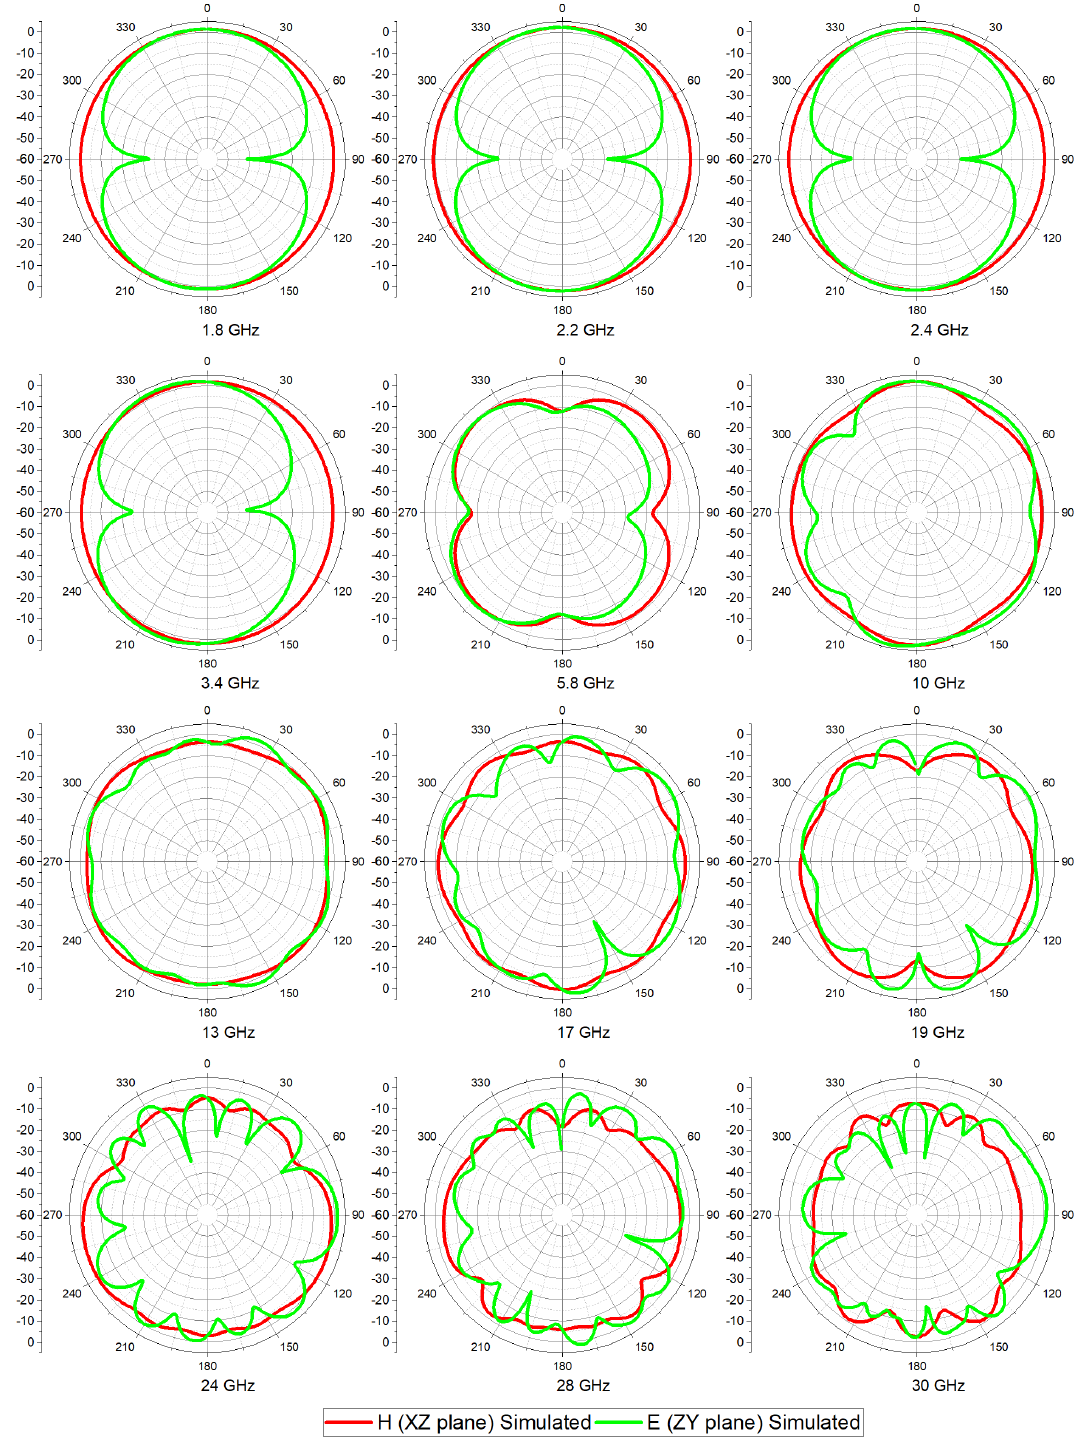
Figure 8. Simulated radiation patterns of the antenna in the E-plane and H-plane. Simulated 3D radiation patterns of the proposed antenna on frequencies 1.8 GHz, 2.2 GHz, 2.4 GHz, 3.4 GHz, 5.8 GHz and 10 GHz in the logaritmic scale are shown